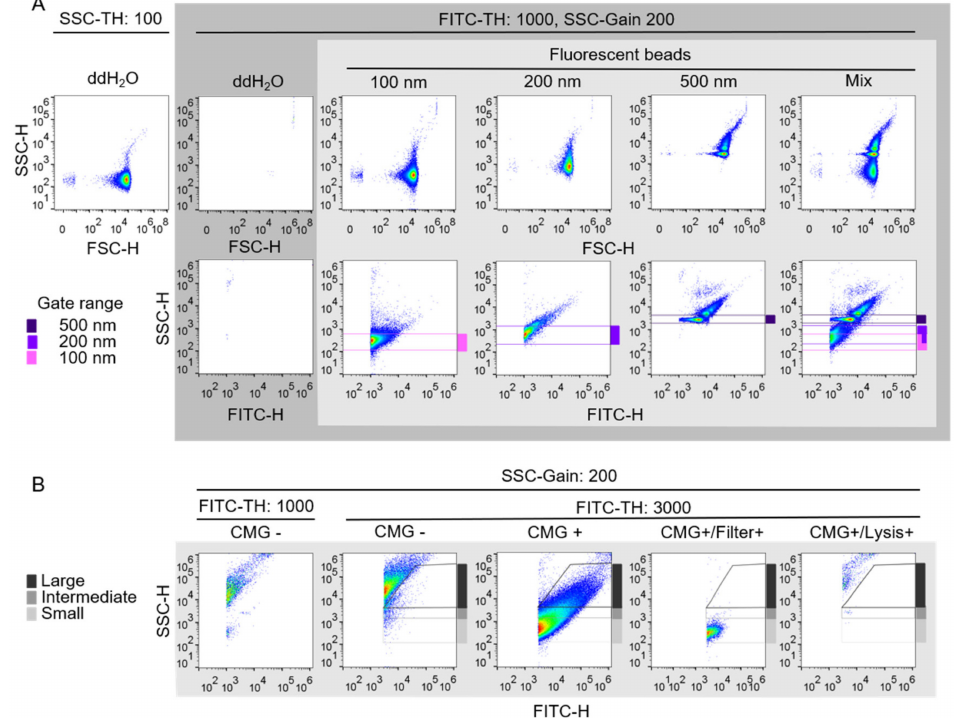
Figure 2. Establishment of fluorescence triggered flow cytometry. ( A ) To exclude unspecific events of particles present in commonly used reagents (top left), the size-dependent SSC default event trigger